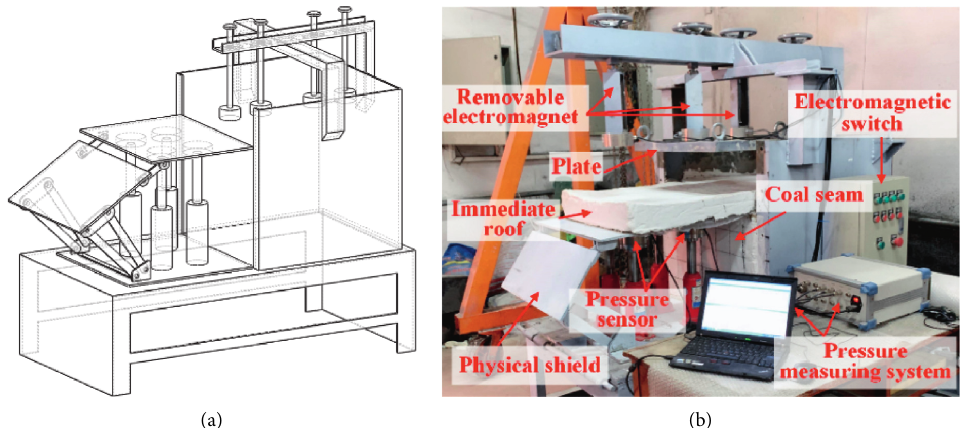
Figure 2: The 3D physical modelling rig for roof dynamic loading test: (a) schematic and (b) constructed model with the measuring